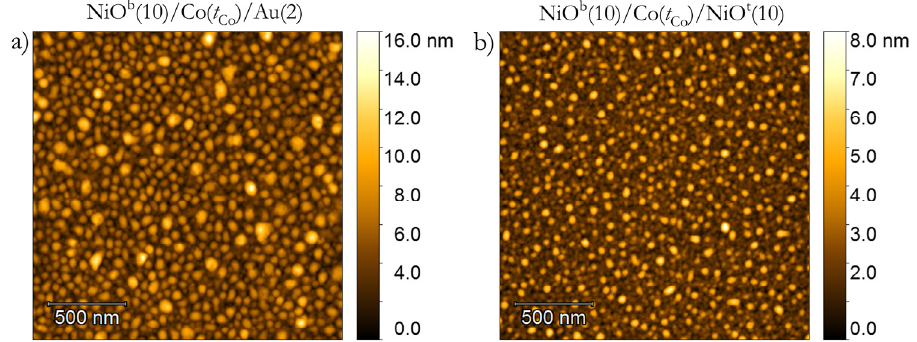
Figure 3. K eff t Co vs. t Co for NiO b /Co/Au and NiO b /Co/NiO t systems in the as-deposited state. The dashed lines indicate Co thickness corresponding to spin reorientation transition ( t SRT = − 2 K S / K V ).